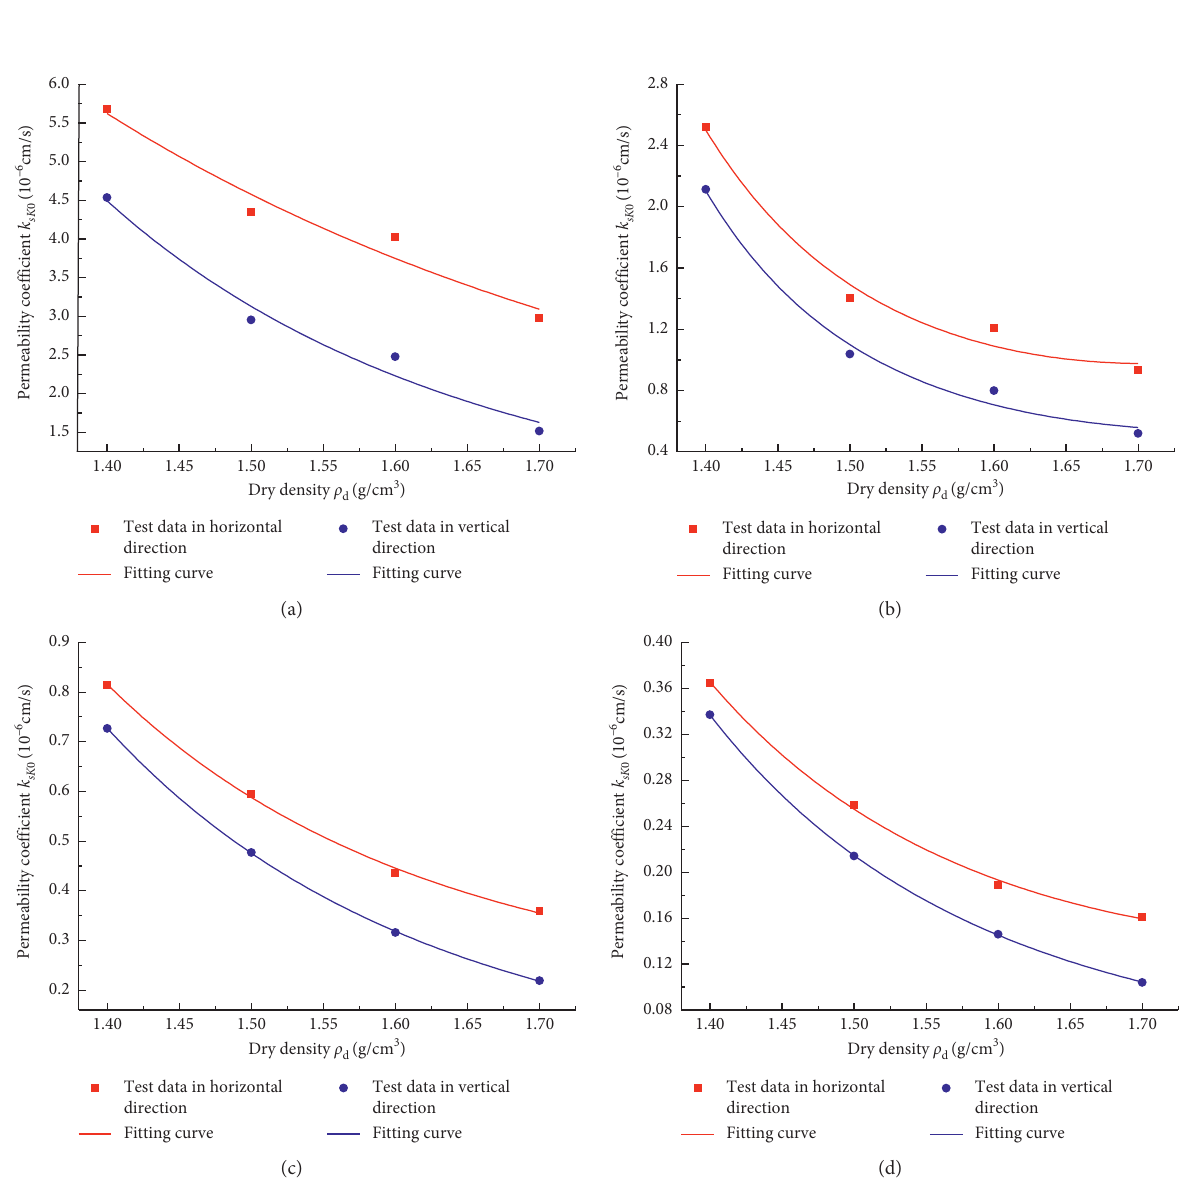
Figure 10: Relationship between the saturated permeability coefficient and the dry density under K σ 3 � 200kPa. (c) σ 3 � 300kPa. (d) σ 3 �